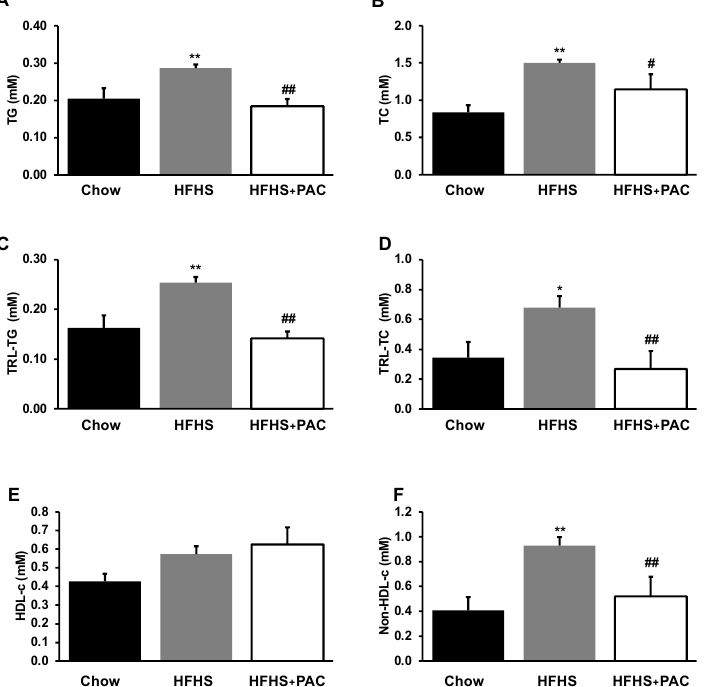
Figure 3. Effect of PAC on dyslipidemia and lipoprotein composition. After 12 weeks diet and before sacrifice, plasma was collected for lipid profile determination. ( A ) triglycerides (TG), ( B ) total cholesterol (TC) as well as ( C ) TG, ( D ) TC in triglyceride-rich lipoprotein fractions (TRL) content, ( E ) HDL-cholesterol and ( F ) non-HDL-cholesterol were analyzed as described in Materials and Methods. Results are presented as mean± SEM for n = 4 – 6 pooled plasma/group. * p < 0.05, ** p < 0.01 vs. chows; # p < 0.05, ## p < 0.01 vs. HFHS mice.